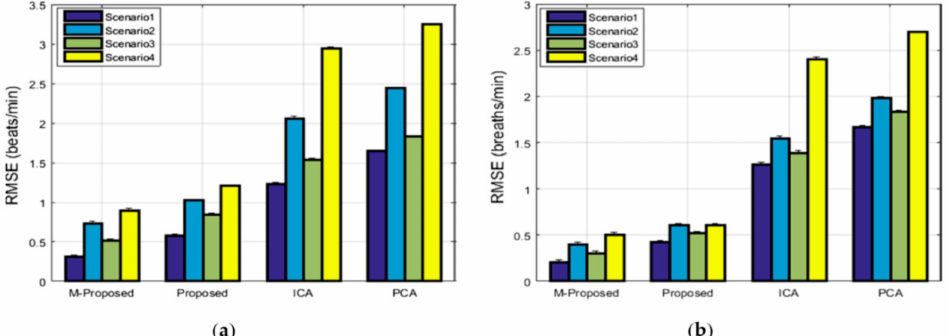
Figure 8. RMSE performance comparison of complete ensemble empirical mode decomposition with adaptive noise (CEEMDAN) and canonical correlation analysis (CCA) techniques for four scenarios [97]. ( a ) RMSE performance comparison for HR, ( b ) RMSE performance comparison for